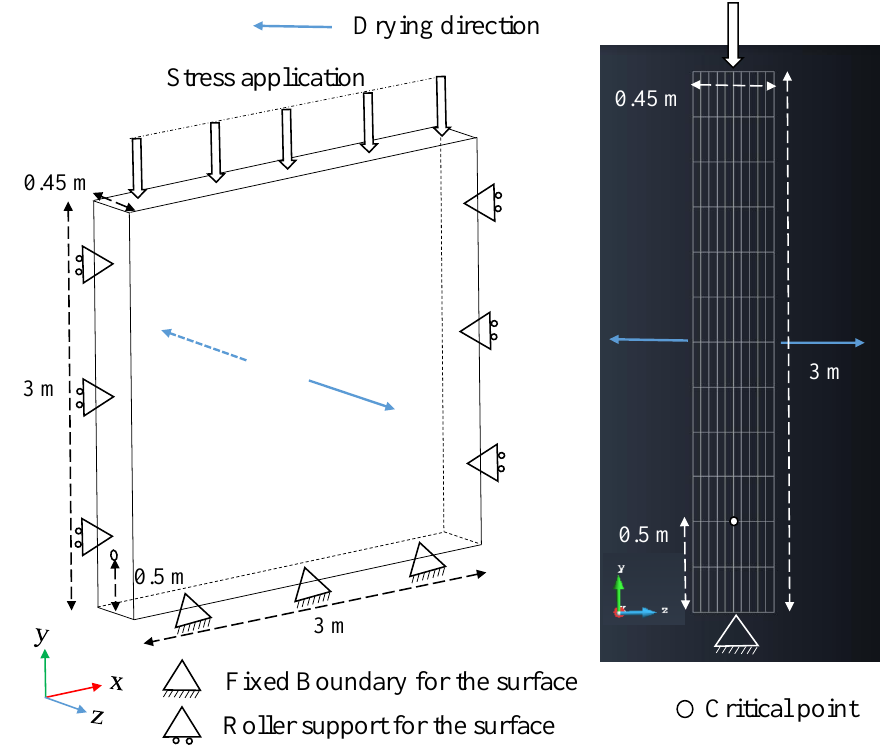
Figure 10. The geometrical model (3D) of the problem ( left ) and the 2D mesh composition ( right ) showing the drying direction and